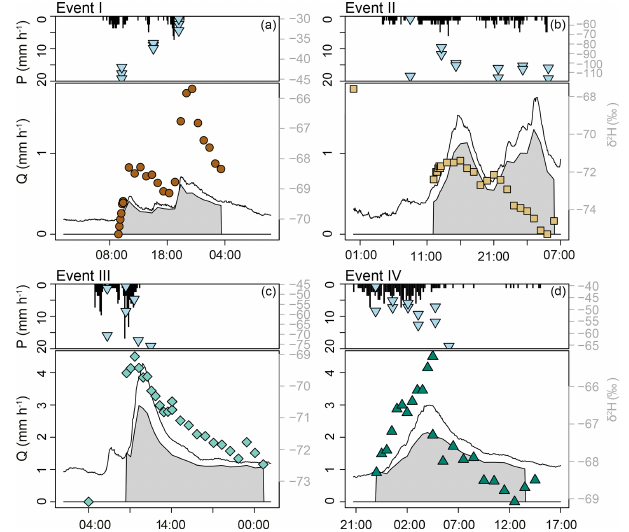
Figure 3. Hydrographs and hyetographs for the four studied events (I–IV). For each event, the upper panel shows the 10min rain- fall intensity (mmh − 1 ; bar graph) and the isotopic composition of the rainfall ( δ 2 H in ‰; light blue triangles), while the lower panel shows the discharge at the catchment outlet (mmh − 1 ; solid line), the isotopic composition of stream water ( δ 2 H in ‰; brown dots, light brown squares, turquoise diamonds and green triangles for events I–IV, respectively), and the pre-event water fraction of streamflow based on two-component hydrograph separation using δ 2 H (grey polygon) as a tracer.